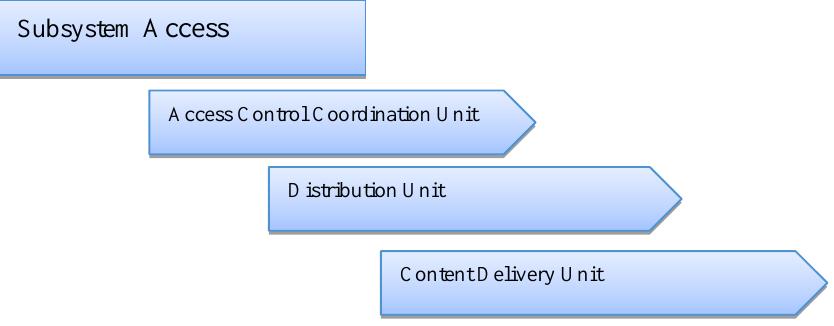
Figure 6. Access control sub-system